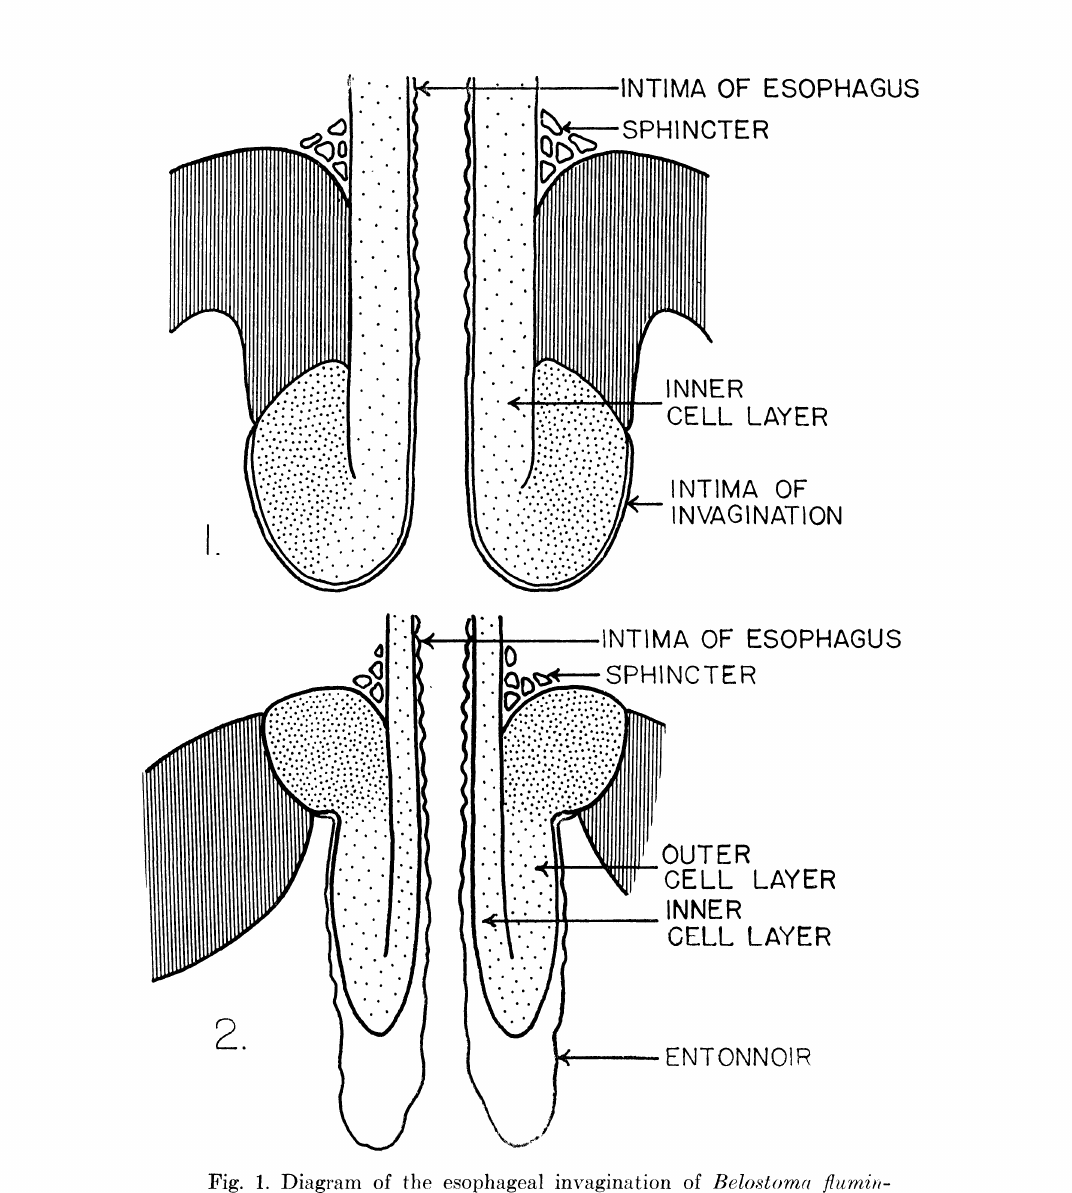
Fig. 1. Diagram of the esophageal invagination of Belostom eum. Heavy stippling indicates annular cell region; light stippling in- dicates rest of foregut epithelium; shading indicates midgut epithelium. Muscle is omitted except for that of the sphincter. 300X. Fig. 2. Diagram of the esophageal invagination of Pelocoris Iemoratus. I,egend same as for Text figure 1.